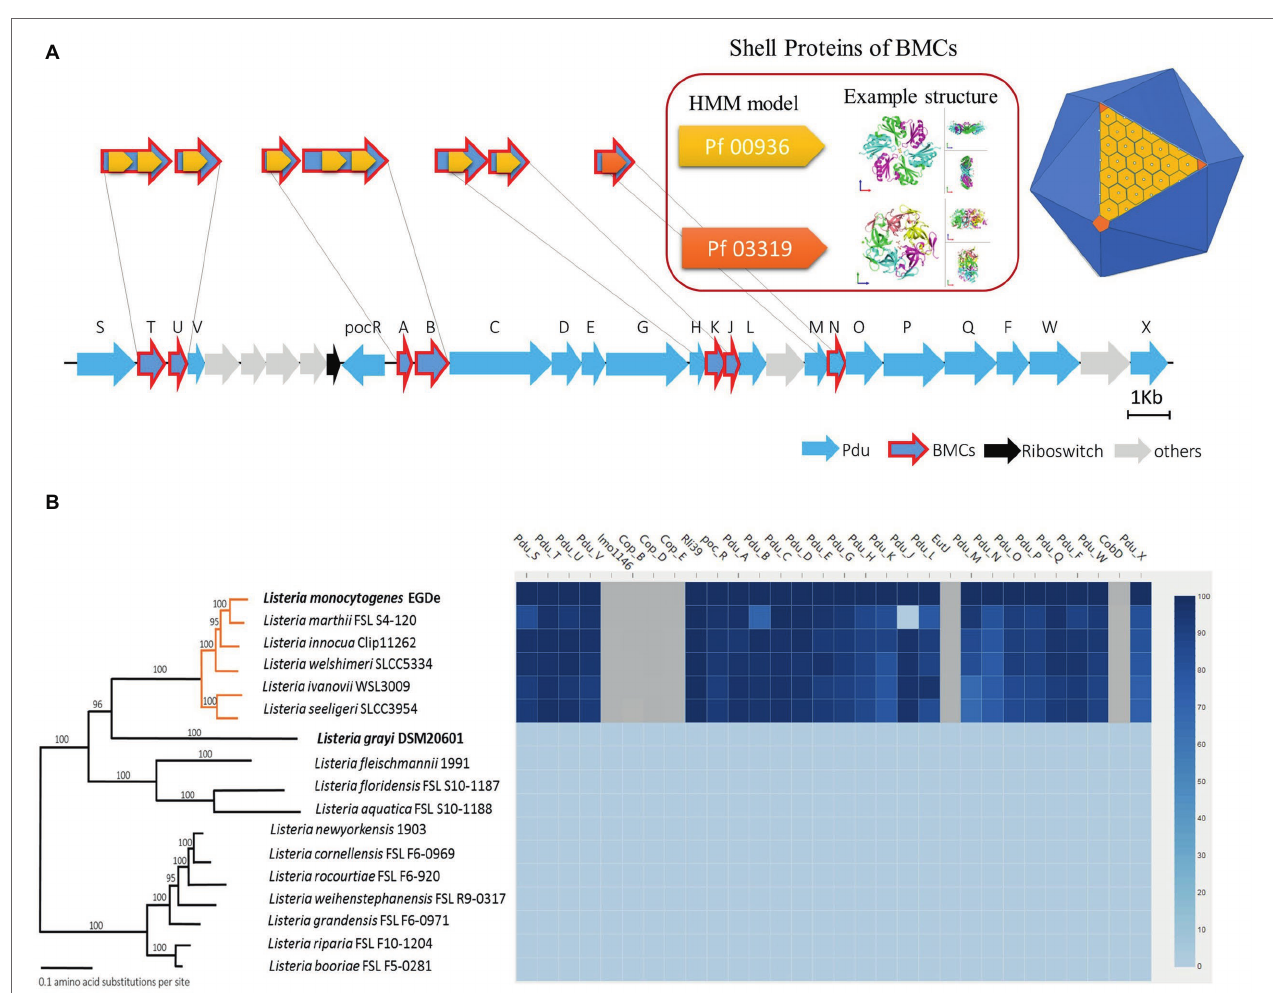
FIGURE 1 | Features, distribution, and alignment of the 1,2-propanediol utilization (Pdu) gene cluster in Listeria species. (A) Scheme of the Pdu gene cluster with BMC presented as an icosahedron in dark blue with one side showing the assembly principle. The classical BMC shell proteins with the Pf00936 domain form hexamers (presented in light orange) to build the surface blocks of the shell, based on the 3D model described by Kerfeld and Yeates et al. The non-classical BMC shell proteins with the domain Pf03319 form pentamers (presented in dark orange) that constitute the vertex blocks of the shell; PduTUABKJ contains Pf00936, while PduN contains Pf00319. Genes encoding Pdu enzymes are presented in blue; genes encoding BMC shell proteins have an additional red outline; riboswitch genes (Riboswitch) are presented in black and non-Pdu genes (others) presented in gray. See Supplementary Table S3 for additional information of the genes in the Pdu cluster. (B) Phylogenetic tree and corresponding similarity heat map of the Pdu cluster in 17 Listeria species; orange lines represent Listeria sensu stricto, black lines represent Listeria sensu lato species. Values on branches represent bootstrap values (>70%) based on 250 bootstrap replicates; Bar, 0.1 amino acid substitutions per site. Protein similarity percentages (%) of the Pdu genes are indicated by blue color intensity according to the scale presented to the right. Species with their names in bold are used in subsequent experiments. Modified from Weller et al.